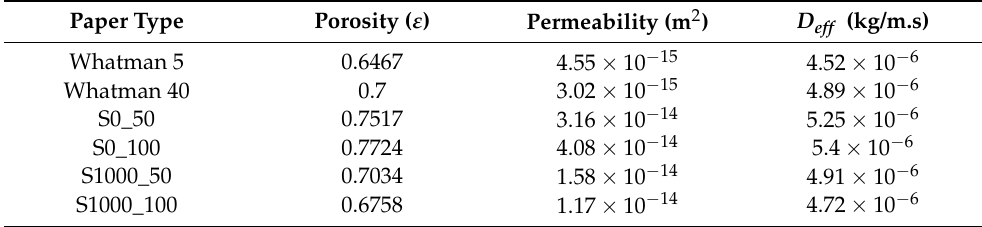
Table 4. Parameters required to model the porous zone in the Fluent Model.